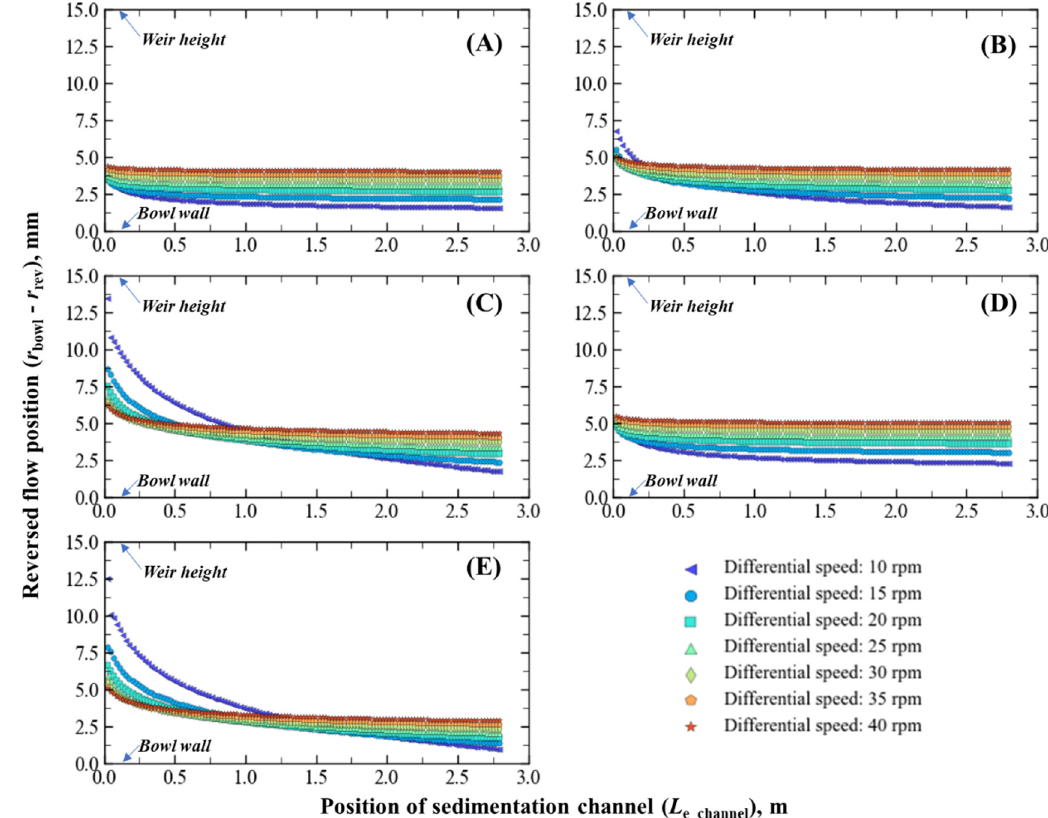
Figure 7. Position of the interface between the reversed flow (backflow) and the positive flow (in direction to the weir) relative to the bowl wall (i.e., the values of ( r bowl – r rev ) as shown in Figure 1) along the sedimentation channel: ( A ) feed rate at 0.0005 m 3 /s and feed solids concentration at 2%; ( B ) feed rate at 0.0005 m 3 /s and feed solids concentration at 5%; ( C ) feed rate at 0.0005 m 3 /s and feed solids concentration at 10%; ( D ) feed rate at 0.0003 m 3 /s and feed solids concentration at 5%; and ( E ) feed rate at 0.001 m 3 /s and feed solids concentration at 5%.